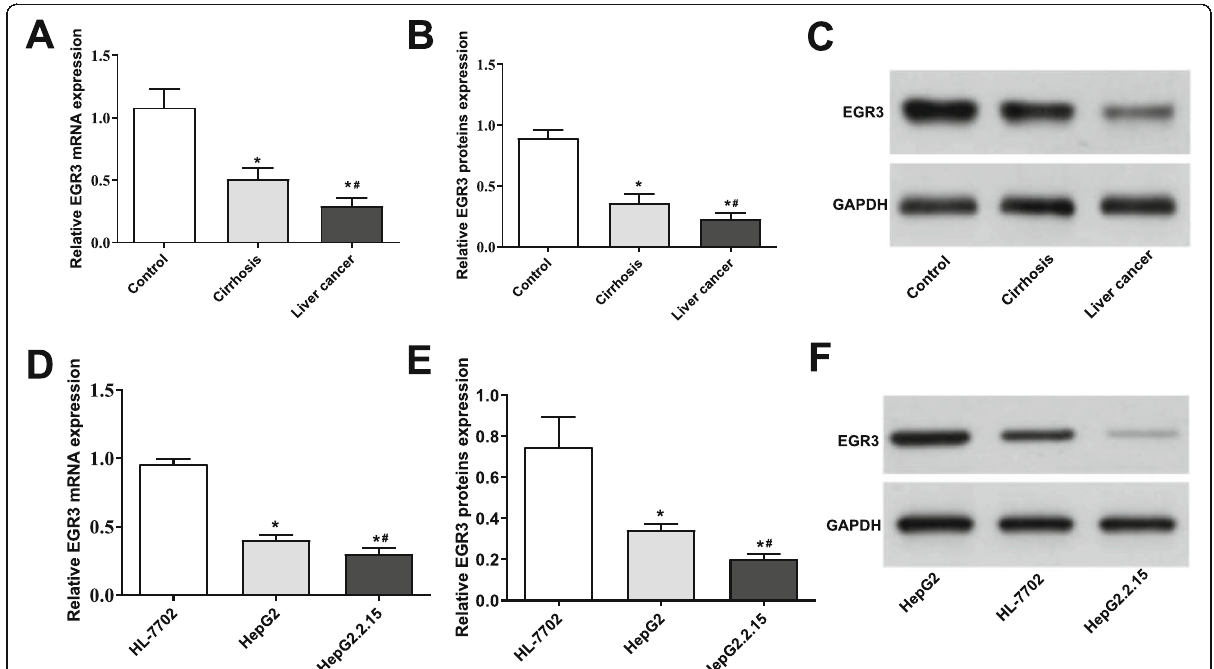
Fig. 6 The expression of EGR3 was decreased in HBV-associated cirrhosis and liver cancer. a-c The mRNA and protein expression of EGR3 was significantly decreased in liver tissues of the Cirrhosis and Liver cancer group. * P < 0.05 compared with the Control group. # P < 0.05 compared with the Cirrhosis group. d-f The mRNA and protein expression of EGR3 was significantly decreased in HepG2 and HepG2.2.15 cells. * P < 0.05 compared with HL-7702 cells. # P < 0.05 compared with HepG2 cells. All experiments were performed in triplicate, and data were expressed as mean ± standard deviation